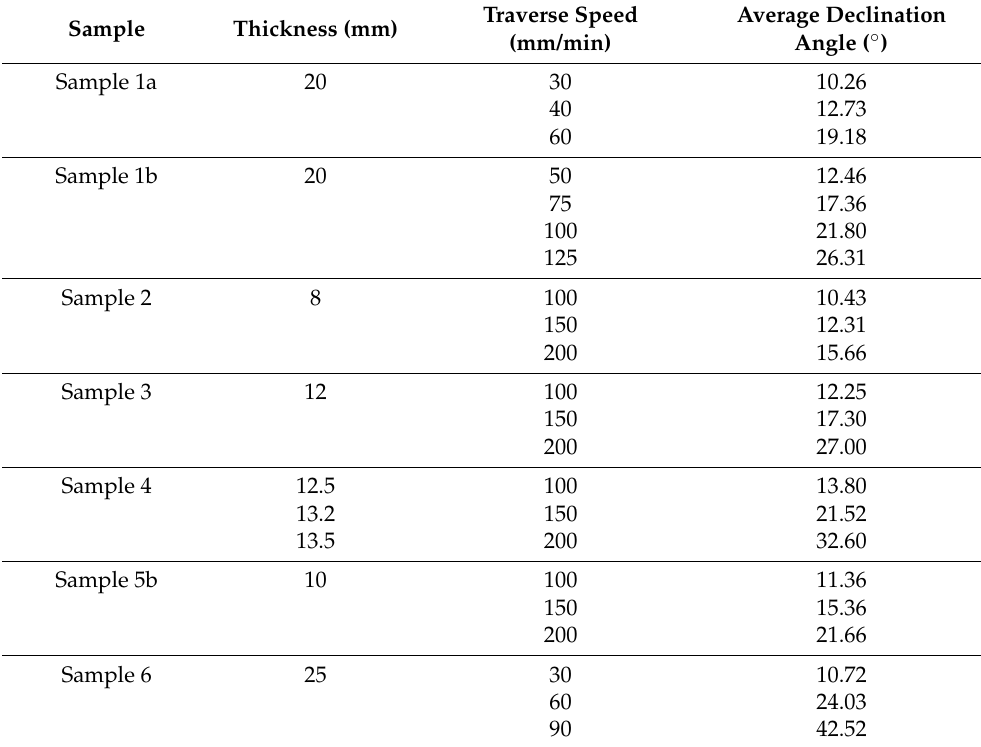
Table 4. Average declination angles measured for examined